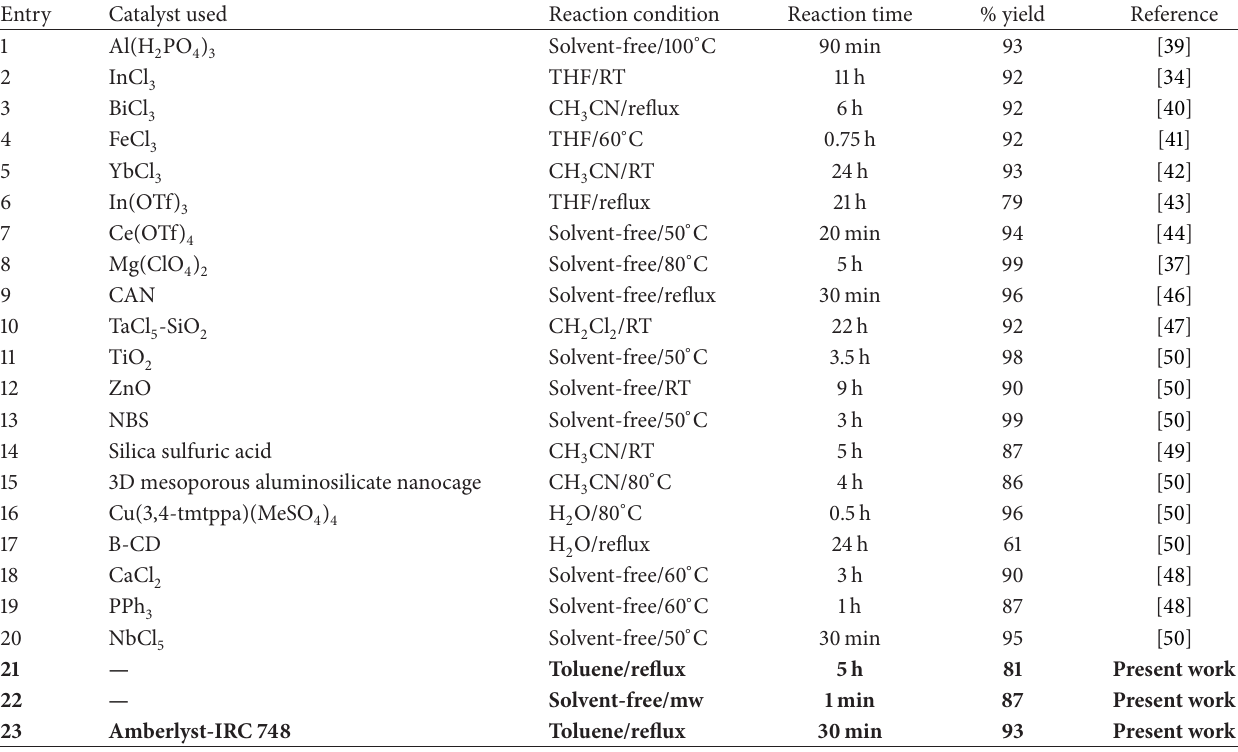
Table 1: Reaction time and percentage yield of 4 in different reaction